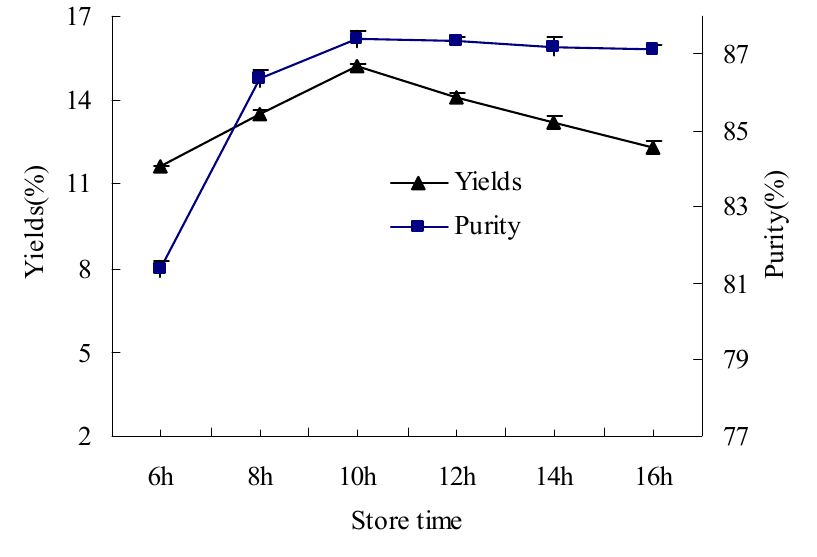
Figure 3. The effect of slurry storage time on yields and purity of glycinin